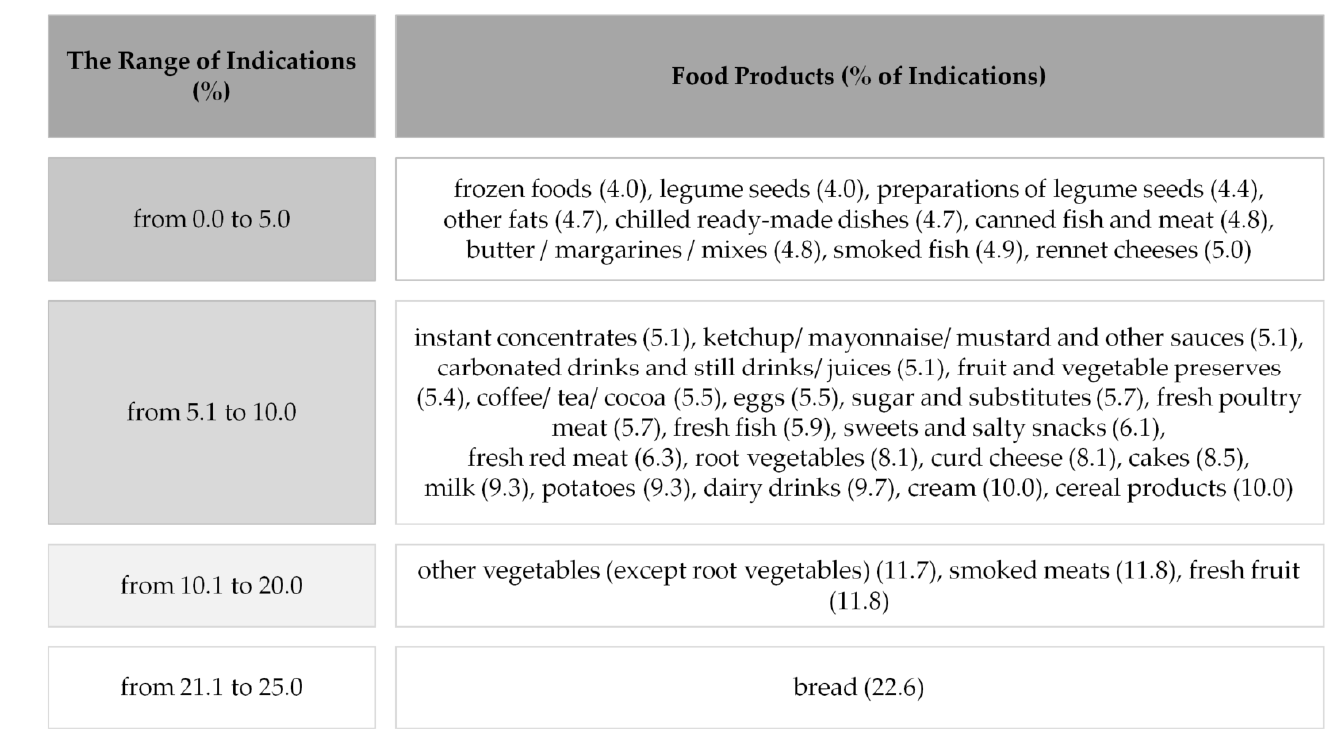
Figure 4. Food products wasted by Polish respondents ( n = 1115) with frequency ‘often/sometimes’. Table 5. Regression analysis results showing relations between the frequency of throwing away food and the reported reasons for doing